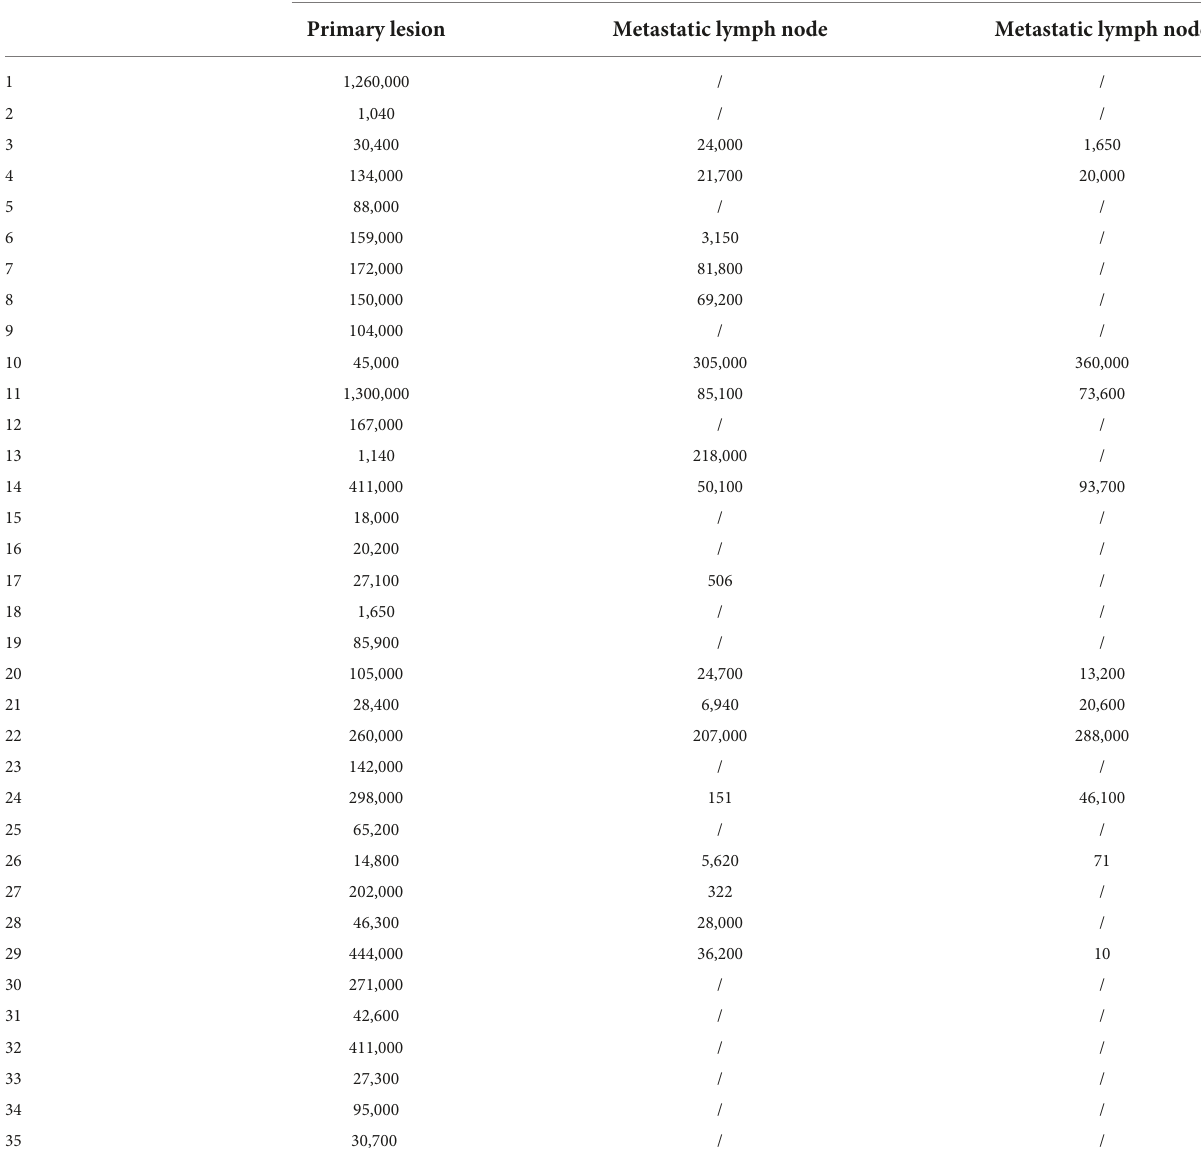
TABLE 3 Epstein–Barr virus (EBV) DNA in the primary and metastatic lymph nodes of patients with gastric cancer with EBV